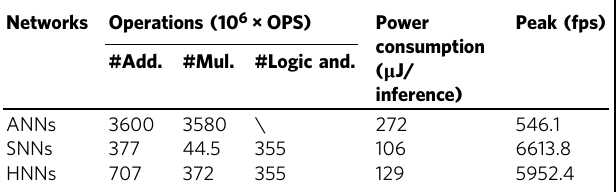
Table 1 Comparison of computational costs among ANNs, SNNs, and